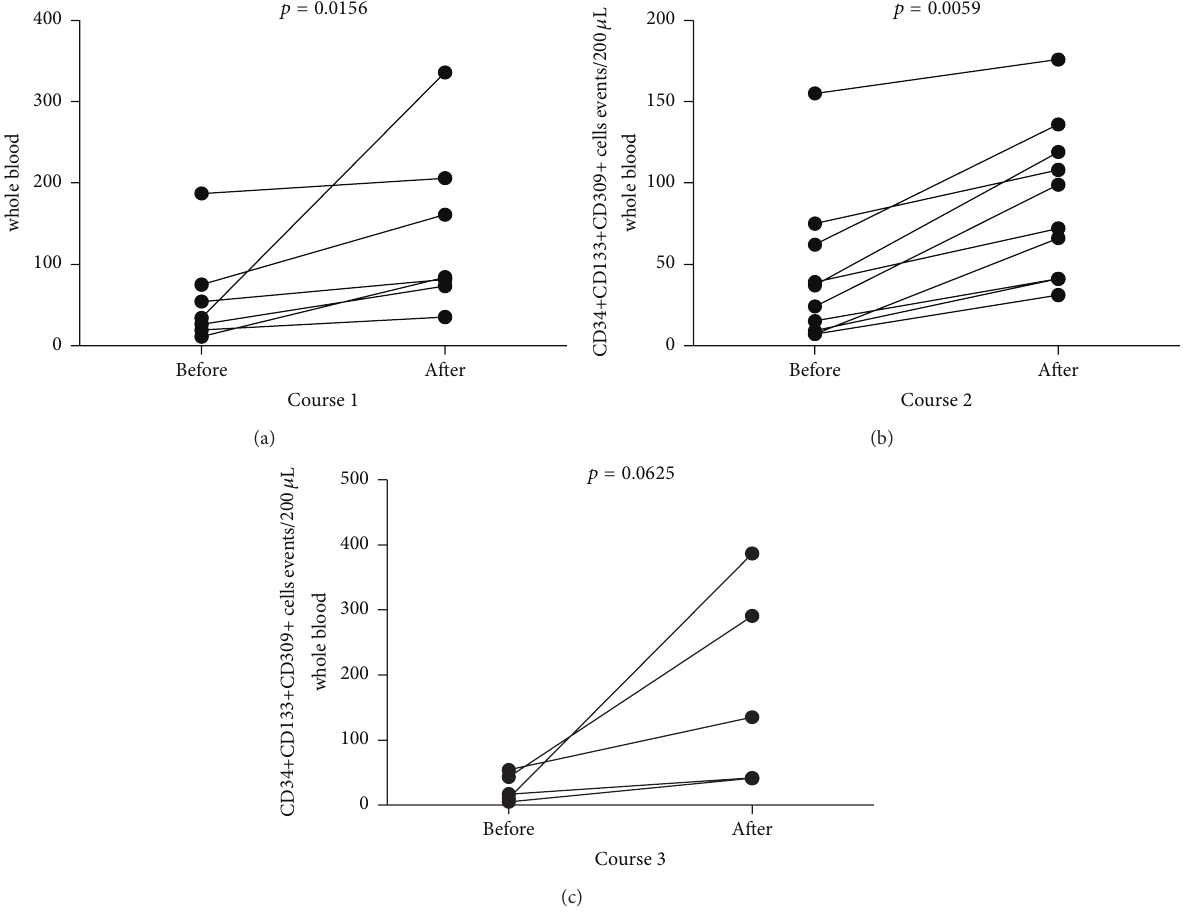
Figure 2: The summary of analyses of EPC numbers (expressing CD34+CD133+CD309+ phenotype) in MD pediatric individuals after